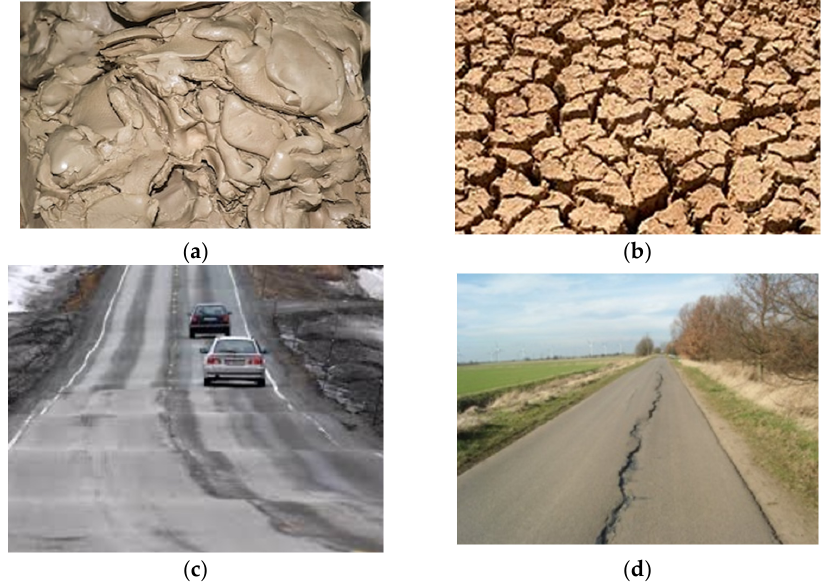
Figure 1. ( a ) Typical wet expansive soil [4]; ( b ) Typical dry expansive soil [4]; ( c ) Uplifting of flexible